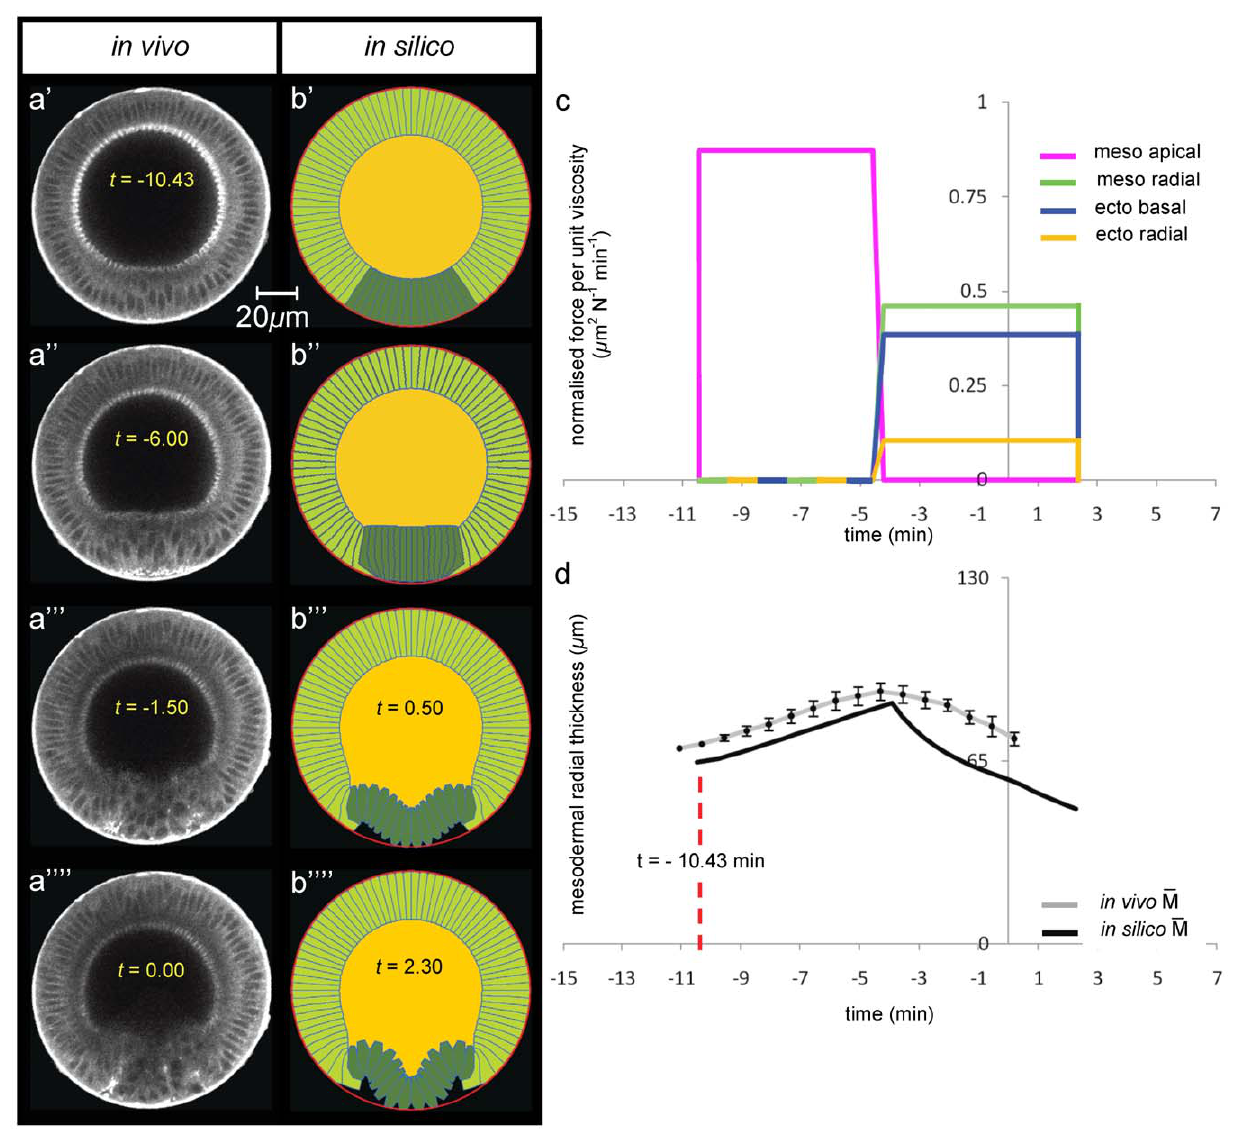
Figure 5. Modelling ventral furrow invagination: armadillo -mutant genotype. ( a ) Selected multi-photon images of in vivo transverse cross- sections of an armadillo -mutant embryo during ventral furrow formation. armadillo -mutant lacks strong apical junctions, and ventral indentation collapses at t= 2 4.22 min. The embryo is labelled with Sqh-GFP and oriented with its dorsal surface upward (Fig. 1a). The time interval between successive frames is 45 sec and instant zero was set by using apical-basal cell height profiles on the dorsal side (Fig. S2c). ( b ) Selected frames (columns) of in silico transverse cross-section of an arm -mutant genotype. Embryo’s 2D geometry is oriented with its dorsal side upward. The undeformed initial configuration (panel b 9 ) corresponds to in vivo deformations at t= 2 10.43 min (see panel d). ( c ) In silico force distributions utilised to simulate invagination in b). ( d ) Time-trends of average radial mesodermal ( (cid:2) MM ) thickness of the epithelium (see schematic in Fig. 3e).